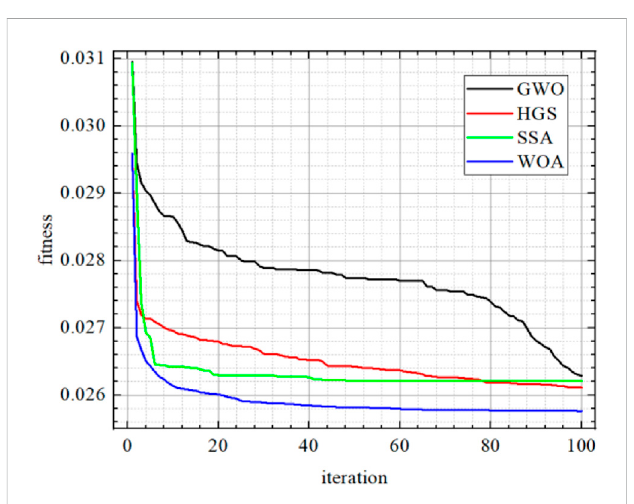
FIGURE 4 Trend of average adaptation of different